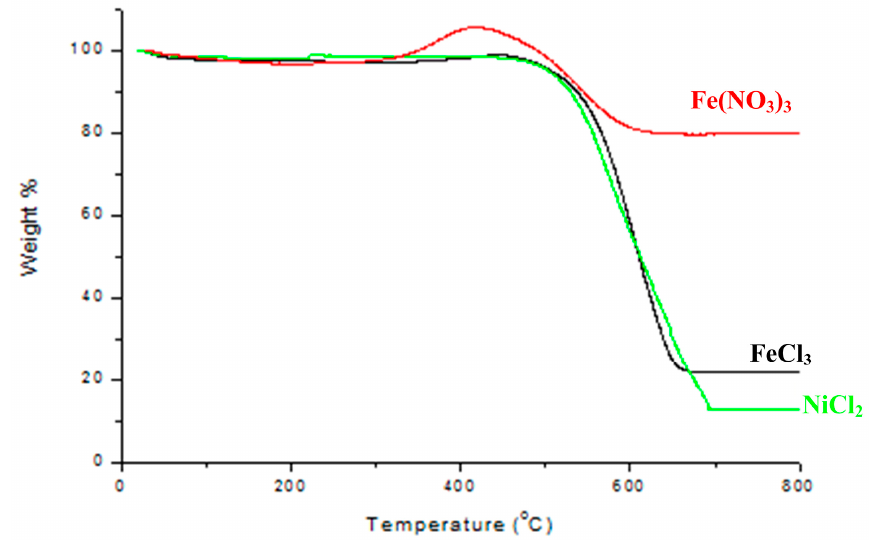
Figure 4. The thermogravimetric analyzer (TGA) analysis of carbon nanotubes obtaining different catalysts.